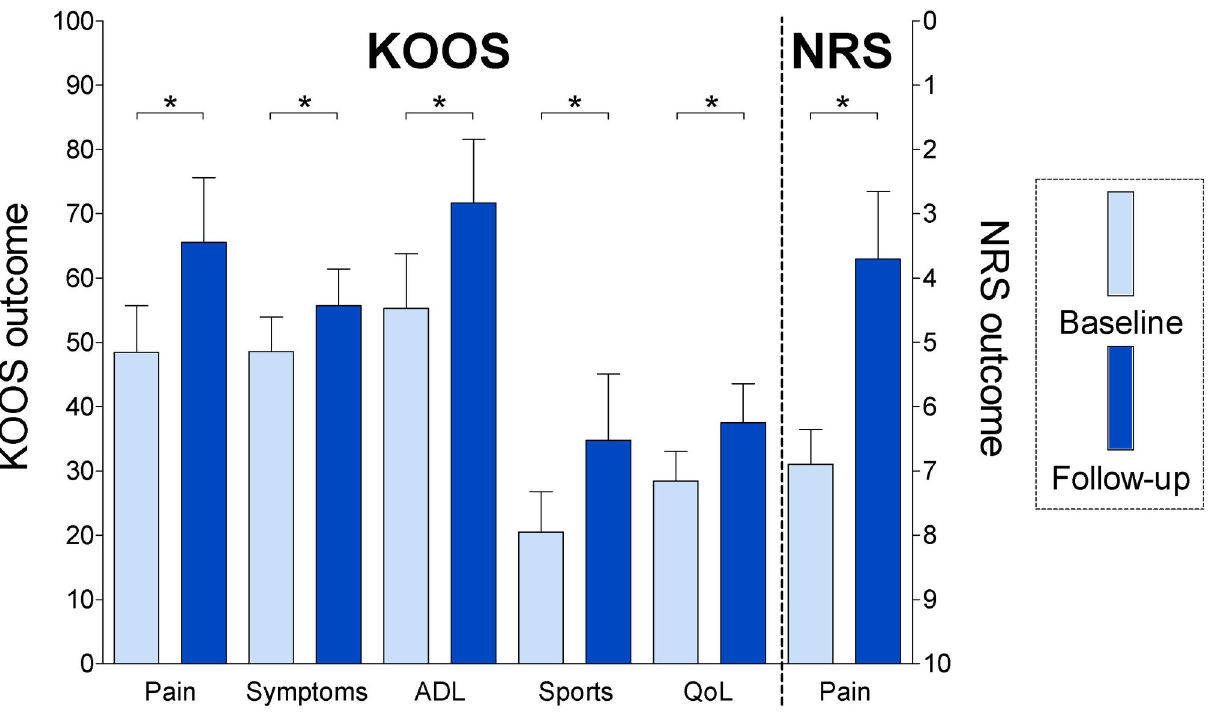
Figure 4. Outcomes of KOOS and NRS questionnaires at baseline and follow-up. Bar graphs showing the KOOS subscales and NRS pain at baseline (light blue box) and at follow-up, 14 weeks after HA injections (dark blue box). The bar represents the mean and the whiskers represent the 95% confidence interval for the mean. HA: hyaluronic acid injections. ADL: activities of daily living, sports: sport and function, and QoL: knee-related quality of life. *: p -values adjusted using Holm’s method